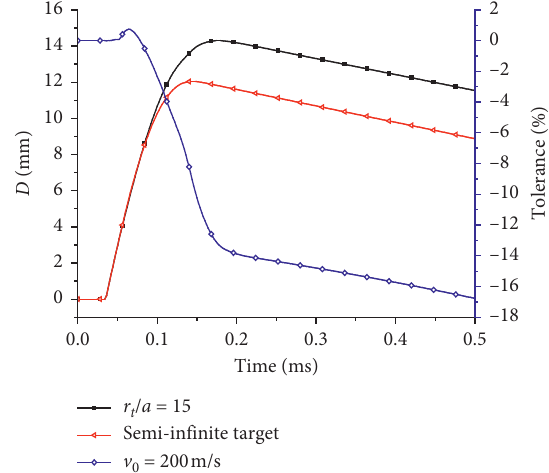
Figure 16: Deviation comparison of the penetration depth for the free boundary ( r t / a � 15) and the nonreflecting boundary ( v � 200m/s).